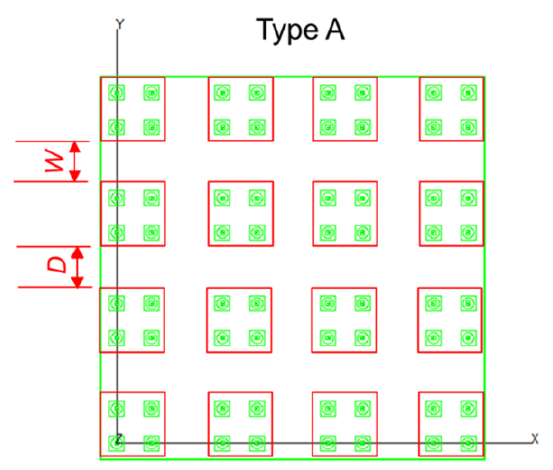
Figure 10. Parameter design change model of type A.